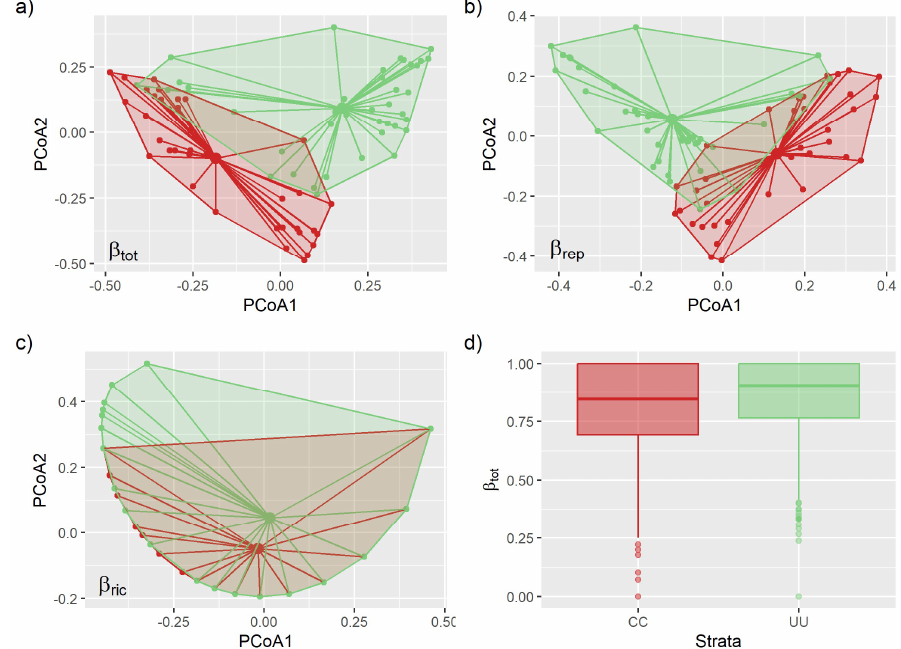
Figure 4. Beta diversity components and their relationship with environmental variables and the stratum of fruit-feeding butterfly assemblages sampled in mixed ombrophilous forest in southern Brazil during November 2016–March 2017 and October 2017–March 2018. ( a – c ) The dispersion of points related to strata for the component of total dissimilarity ( β tot), the component of abundance replacement ( β rep), and the component of abundance differences ( β ric), respectively. ( d ) Boxplot showing the effects of strata in β tot, indicating a larger dissimilarity among understory sites (UU, green color) than among canopy sites (CC, red color). Table 3. Effects of environmental variables on partitioning beta diversity dissimilarity in fruit-feeding butterfly assemblages sampled in mixed ombrophilous forest in southern Brazil during Novem- dissimilarity among pairwise sites; β rep—component related to abundance replacement among sites; β ric—component of abundance difference due to the gain/loss of individuals among sites.; df—degrees of freedom; SumOfSqs—sum of squares. Bold values indicate the significant terms at a p threshold of 0.05.